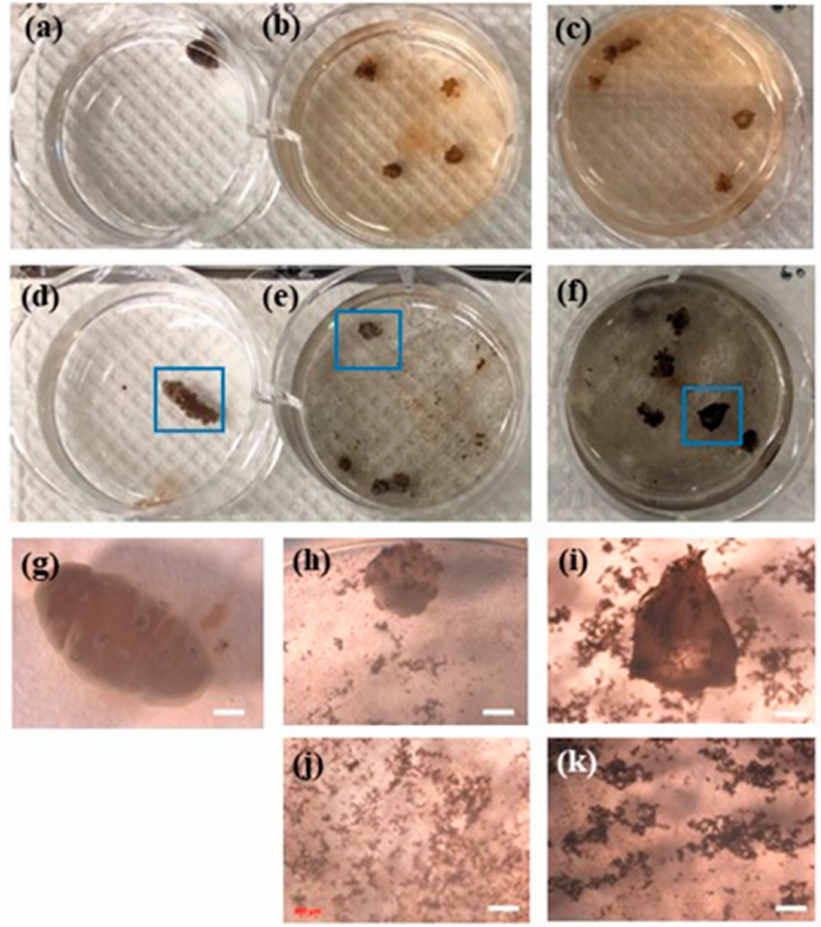
Figure 6. The process of black pigment being released from the coral tentacles into seawater. ( a – c ) The tentacles of S. flexibilis were collected in 6-well plates; ( a , d ) a complete tentacle; ( b , e ) small pieces of tentacles incubated in FSW (36‰); ( c , f ) small pieces of tentacles incubated in high-salinity FSW (60‰). After 4 h, the corals and black pigment were observed by ( d – f ) phone camera and ( g – k ) microscopy, with the white bar representing 1 mm; ( g – i ) are the magnified images of the tentacles in the blue box in ( d – f ), respectively; ( j , k ) the enlarged image of the black pigment released into the solution in ( e , f ),